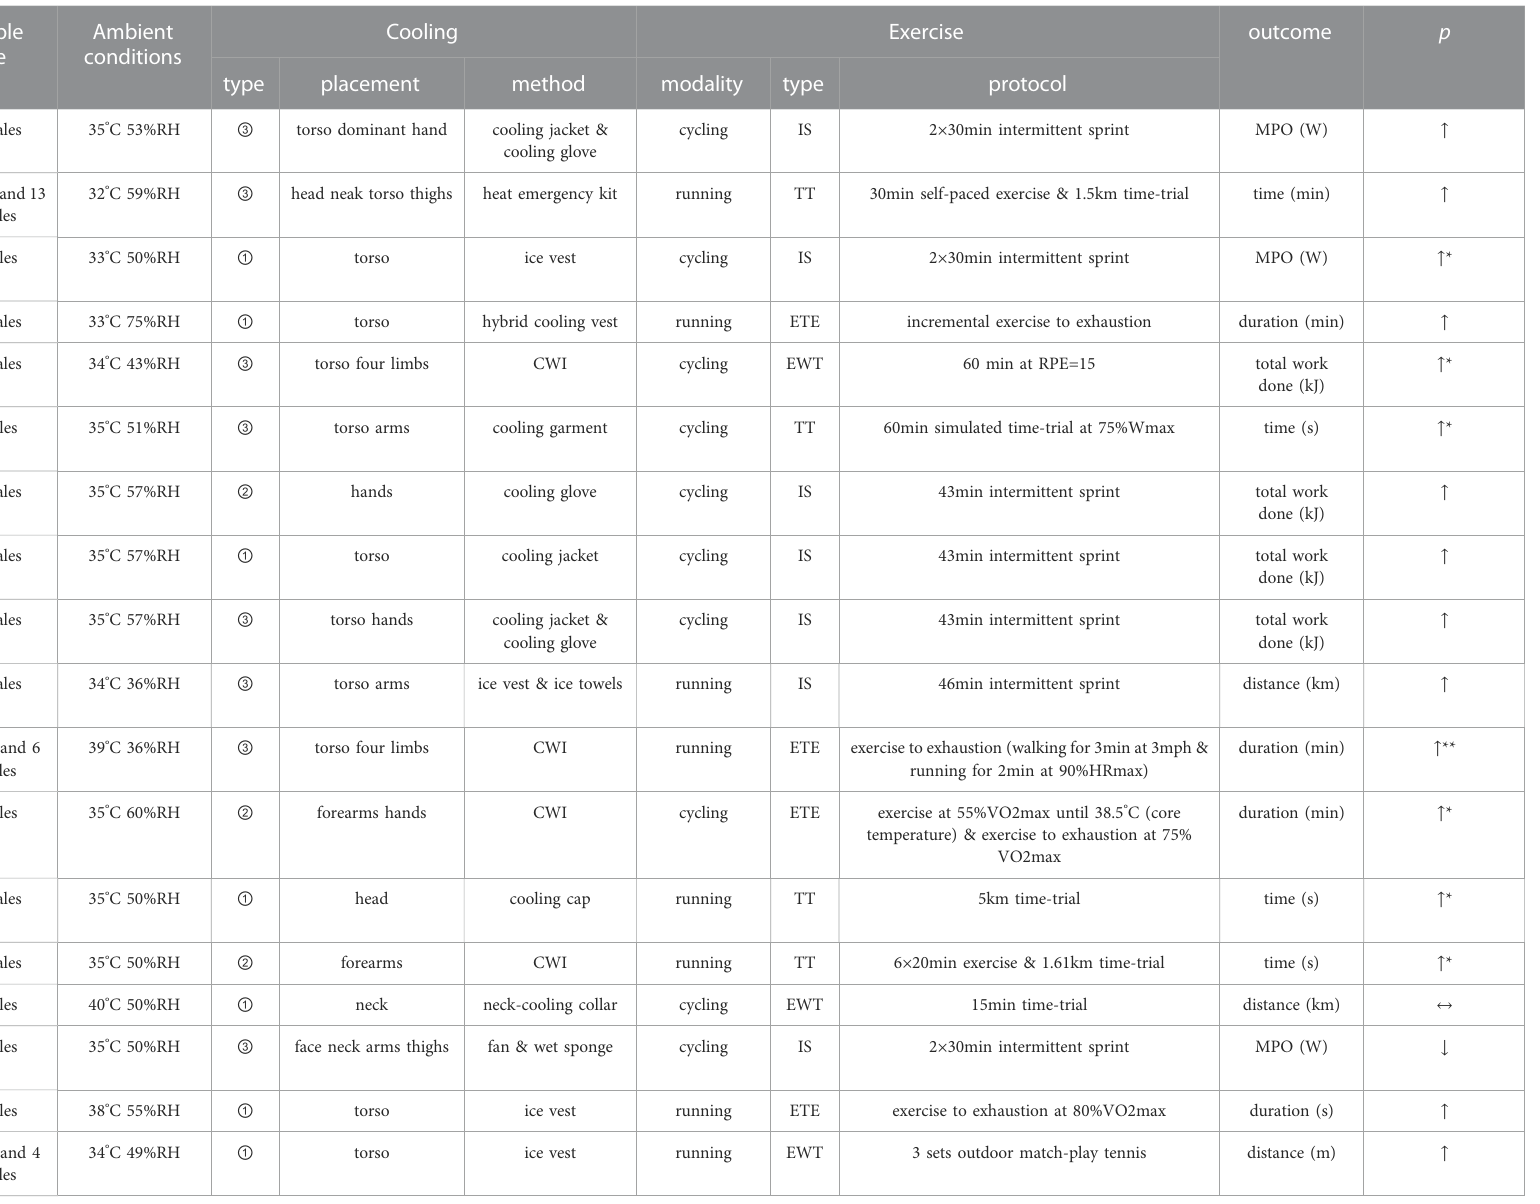
Naito et al. (2022) 4 males and 4 34 ° C 49%RH ① torso ice vest running EWT 3 sets outdoor match-play tennis distance (m) ↑ females RH:relativehumidity; ① :centralcooling; ② :peripheralcooling; ③ :centralandperipheralcooling;CWI:coldwaterimmersion;IS:intermittentsprint;ETE:exercisetoexhaustion;EWT:exercisewithinthe fi xedtimeorsets;TT:time-trial;PPO:peakpoweroutput;MPO: mean power output; RPO: relative power output; ↑ : increased compared with control; ↓ : decreased compared with control; ← → : no change compared with control; *: p & 0.05; **: p &